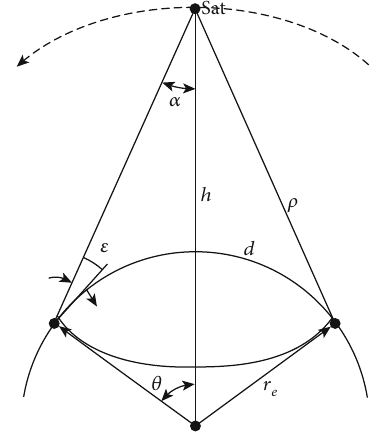
Figure 5: Circle covering a satellite.